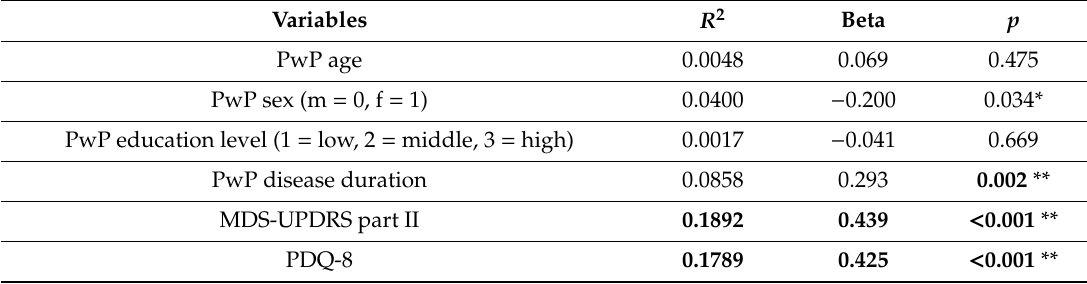
Table 2. Linear regression analysis of factors associated with caregiver burden measured by